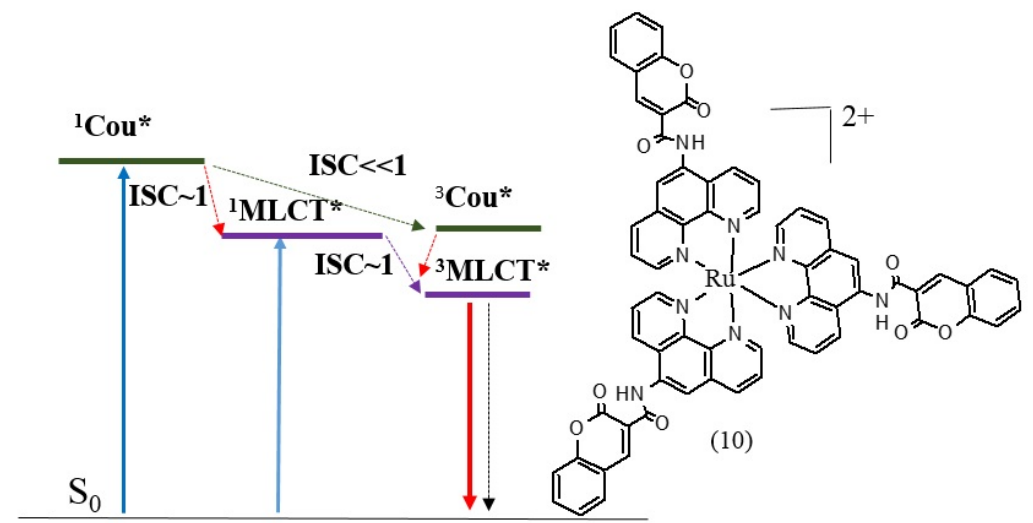
Figure 30. Energy level diagram showing Ru(II) complex having a light-harvesting coumarin ligand.